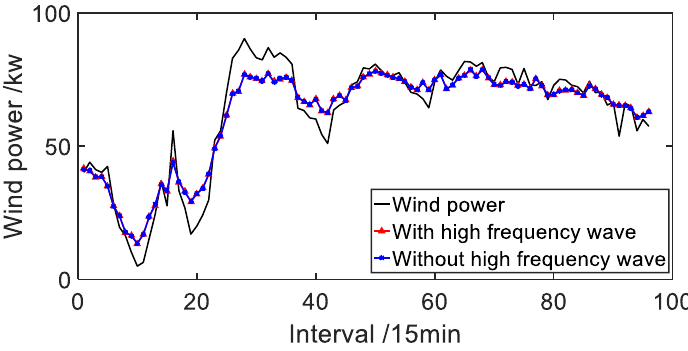
/ without high-frequency wave wind power Figure 9. With/without high-frequency wave wind power prediction. Figure 9. With/without high-frequency wave wind power prediction. Figure 9. With